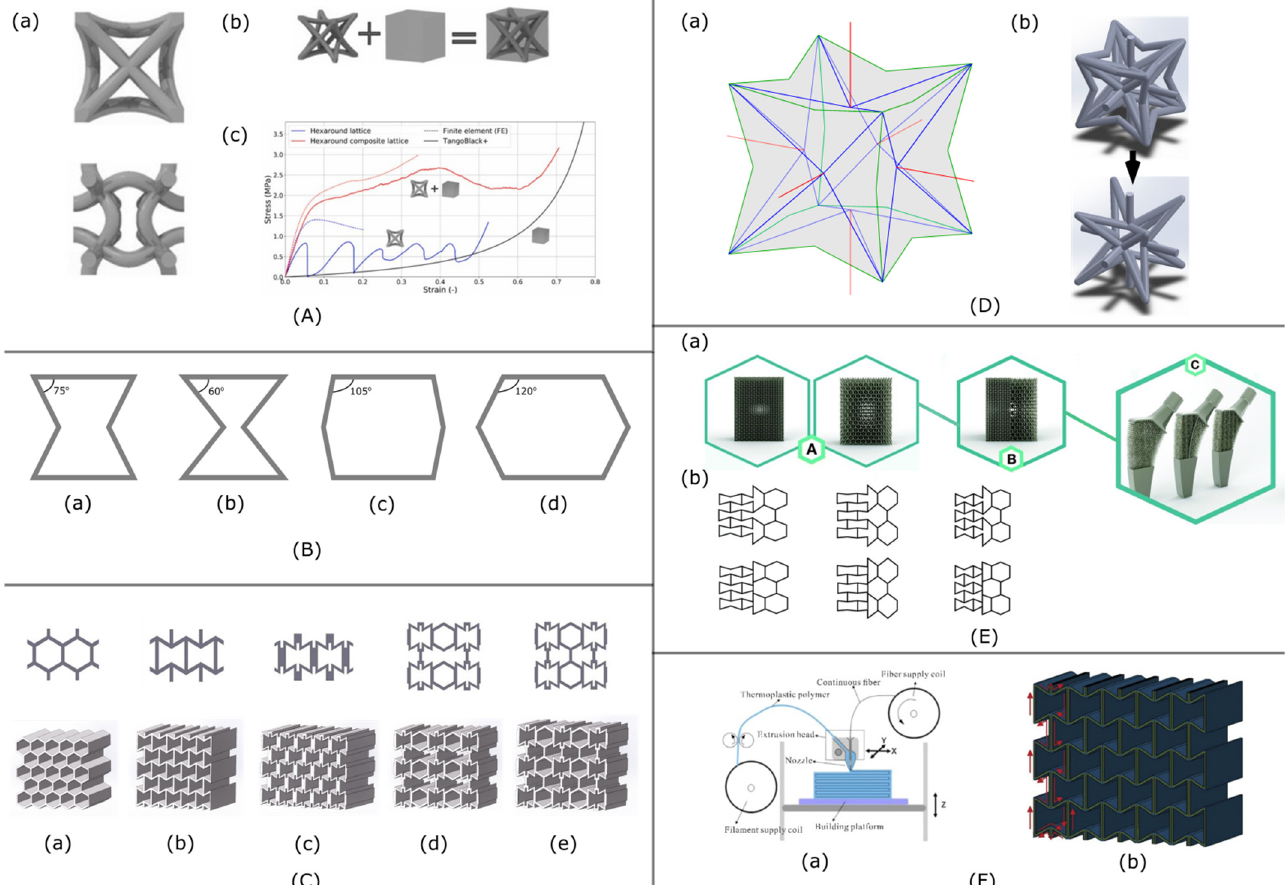
Figure 1. Auxetic structures. ( A ): ( a ) Hexaround (top) and Warmuth (bottom) cells in 2D. ( b ) Filling strategy. ( c ) Stress – strain graph for Hexaround lattice, filler and composite [26]. ( B ): Schematic design of individual cell dimensions for: ( a ) – 15° re-entrant cells, ( b ) – 30° re-entrant cells, ( c ) +15° honeycomb cells and ( d ) +30° honeycomb cells. ( C ): ( a ) honeycomb, ( b ) re-entrant and ( c–e ) hybrid honeycomb structures [15]. ( D ): ( a ) An idealized 3D re-entrant unit cell with its struts colored in red, blue and green depending on the strut type, ( b ) general and lightened re-entrant structure cells [27]. ( E ): ( a ) Schematic drawing of ( A ) auxetic and conventional meta-biomaterials, (B) hybrid meta- biomaterials and (C) meta-implants; and ( b ) design of six hybrid meta-biomaterials [28]. ( F ): ( a ) FDM printing setup and ( b ) schematic of CFRTPC auxetic honeycomb with specific printing path marked in red lines [29].